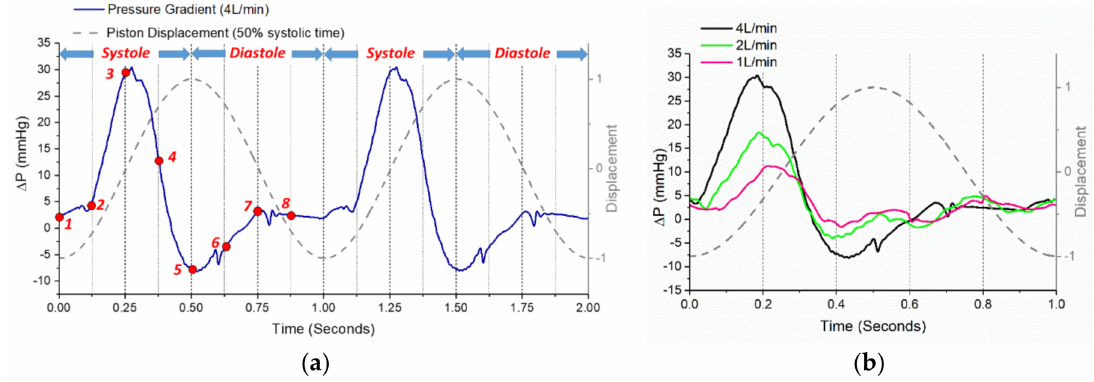
Figure 4. Pressure gradient waveforms ( a ) the pressure gradient in two cardiac cycles and the particle image velocimetry (PIV) measurement phases; ( b ) the pressure gradients under different reduced cardiac